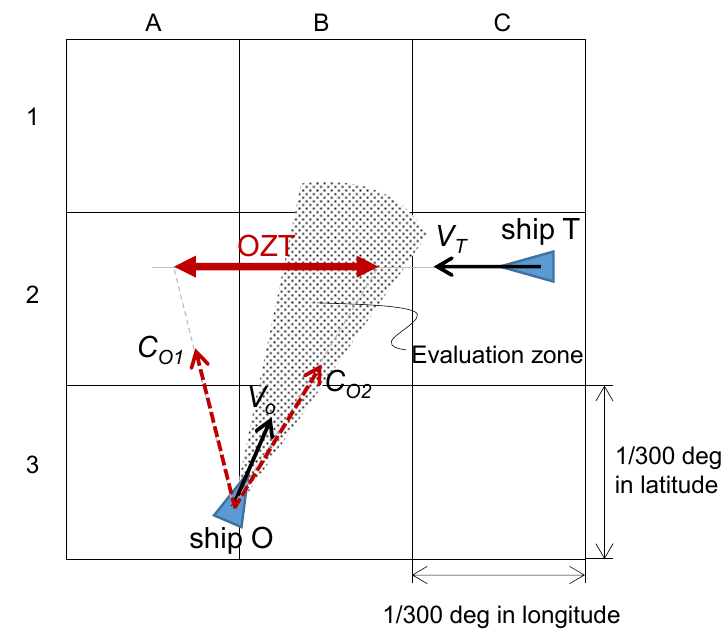
Figure 4. Identification of the dangerous OZT using EZ for safety assessment.